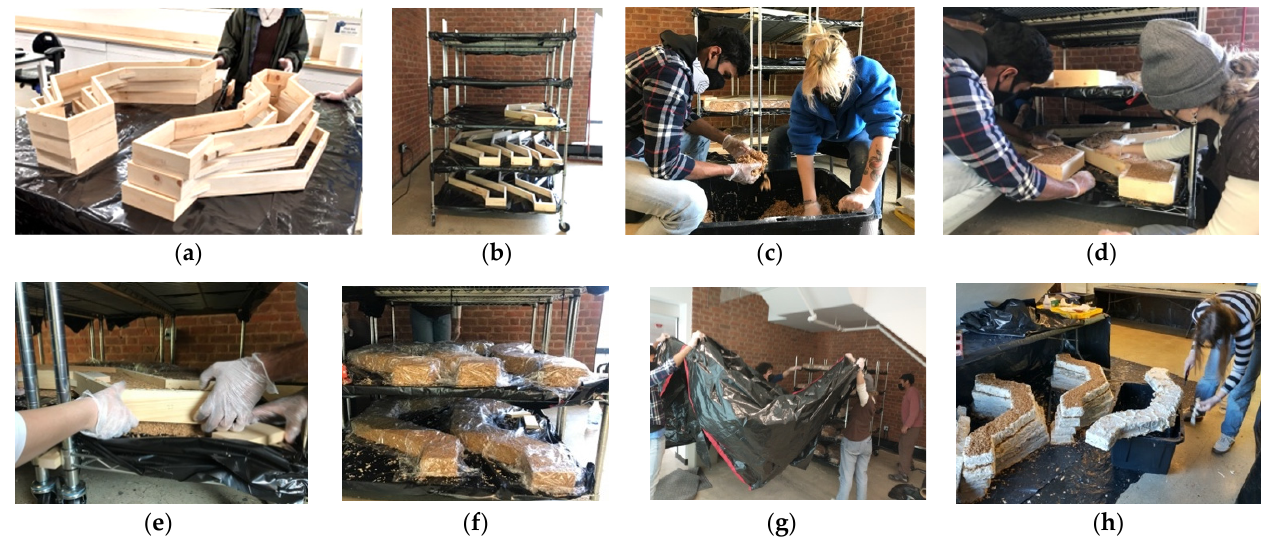
Figure 9. Preparation and process for forming and growing myco-material slabs: ( a ) re-usable wood formworks created in the first days of the workshop; ( b ) growing cart in its space under a staircase in the school of architecture; ( c ) fiberizing the living hemp substrate and mixing in additives prior to packing the formwork; ( d ) hand packing the wood formwork directly on the grow cart; ( e ) removing the mold for reuse; ( f ) slabs individually wrapped in food-safe plastic to keep the fibers humid and warm; ( g ) plastic “cloak” which covered the entire grow cart to keep growing specimens dark warm and humid; ( h ) myco-welding slabs with loose inoculated substrate as mortar. Photos by the author and Leila Ehtesham.